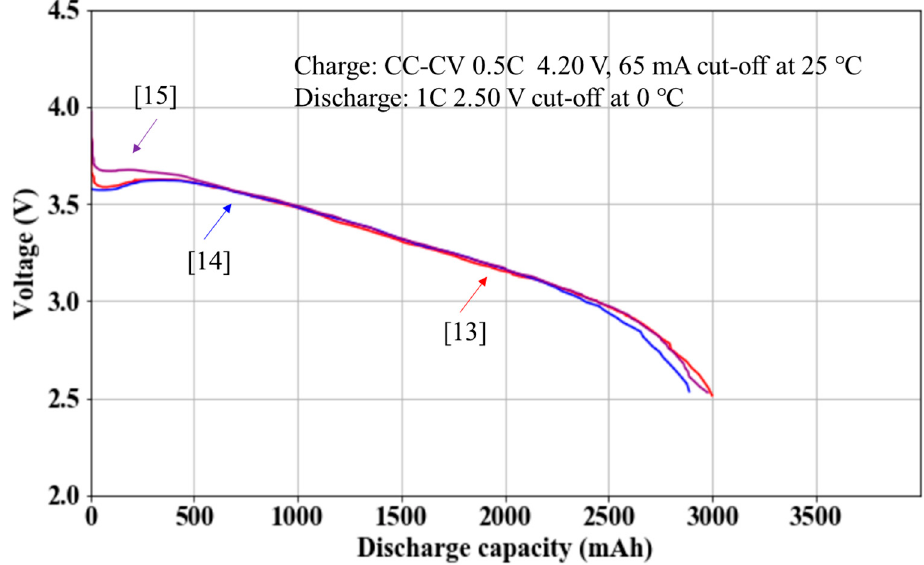
Figure 5. Observed inconsistent discharge characteristics at 0 ◦ C, 1 C from different sources for Panasonic NCR18650B cells.